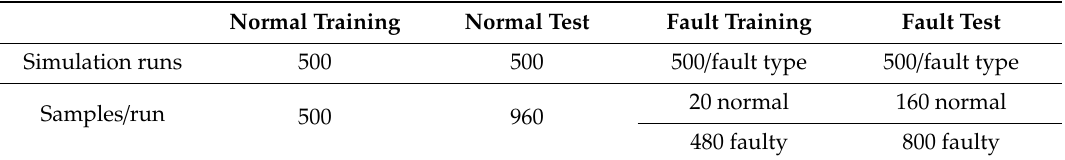
Table 1. Number of samples in each data